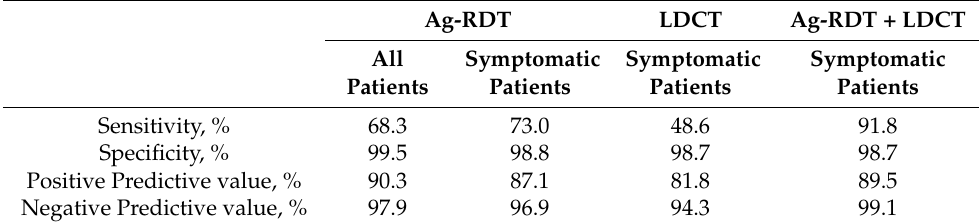
Table 2. Overall diagnostic values of Ag-RDT and